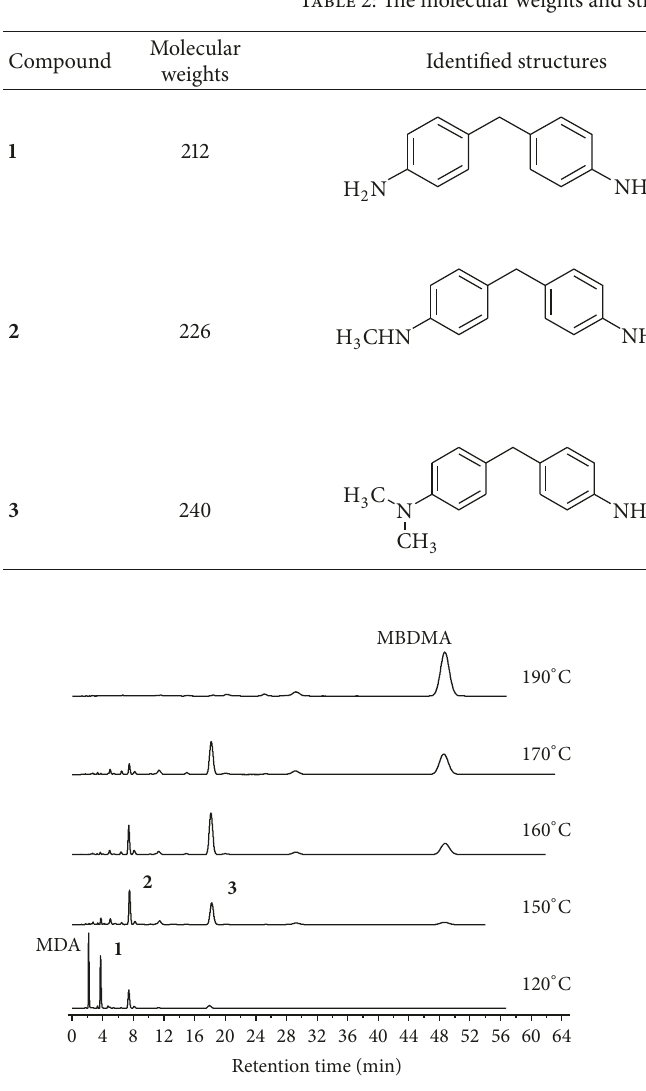
Figure 3: Liquid chromatograms obtained after the reaction between MDA and DMC under different temperatures. Reaction conditions: DMC 27.0 g (0.30 mol), MDA 1.98 g (0.01mol), NaY